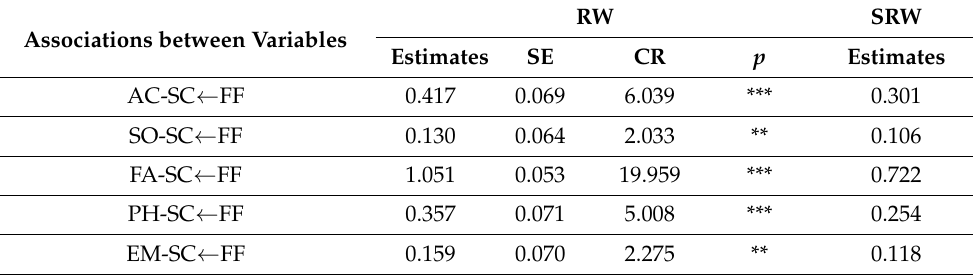
Table 4. Results of the proposed structural model for participants practicing less than 3 h of PA per week. Associations between Variables